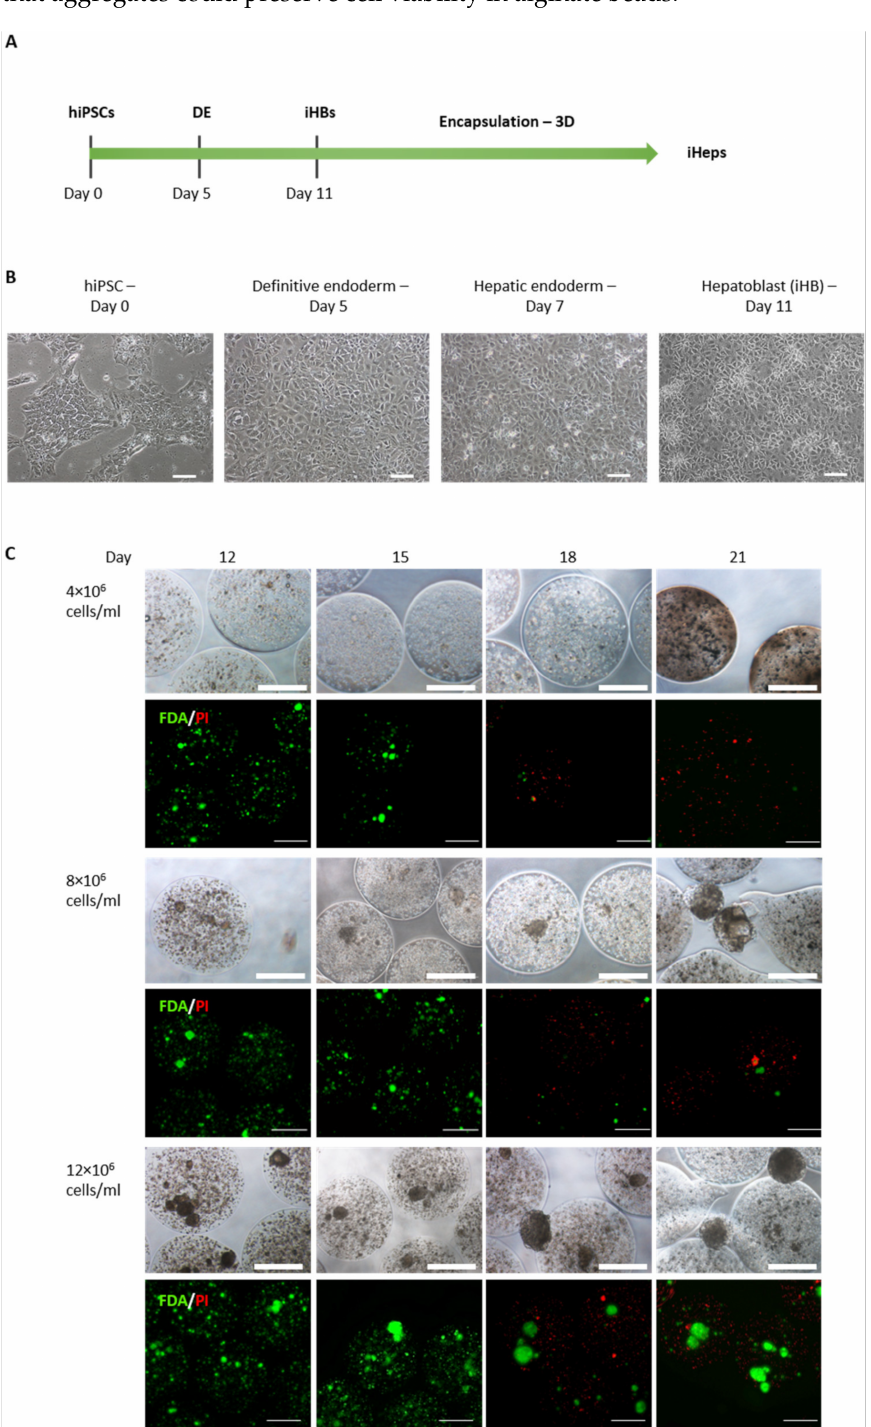
Figure 1. Production of iHeps from hiPSCs and encapsulation as single cells. ( A ) Experimental procedure indicating the course of the differentiation of hiPSCs into hepatoblasts. ( B ) Brightfield images of hiPSC differentiation steps into definitive endoderm (Day 5) and hepatoblasts (Day 11) (scale bar 100 µ m). ( C ) Brightfield and fluorescence microscope images of encapsulated iHBs at three cell densities and viability assay during the differentiation procedure. Viable cells are shown in green (fluorescein diacetate—FDA) and dead cells in red (propidium iodide—PI) (scale bar 500 µ